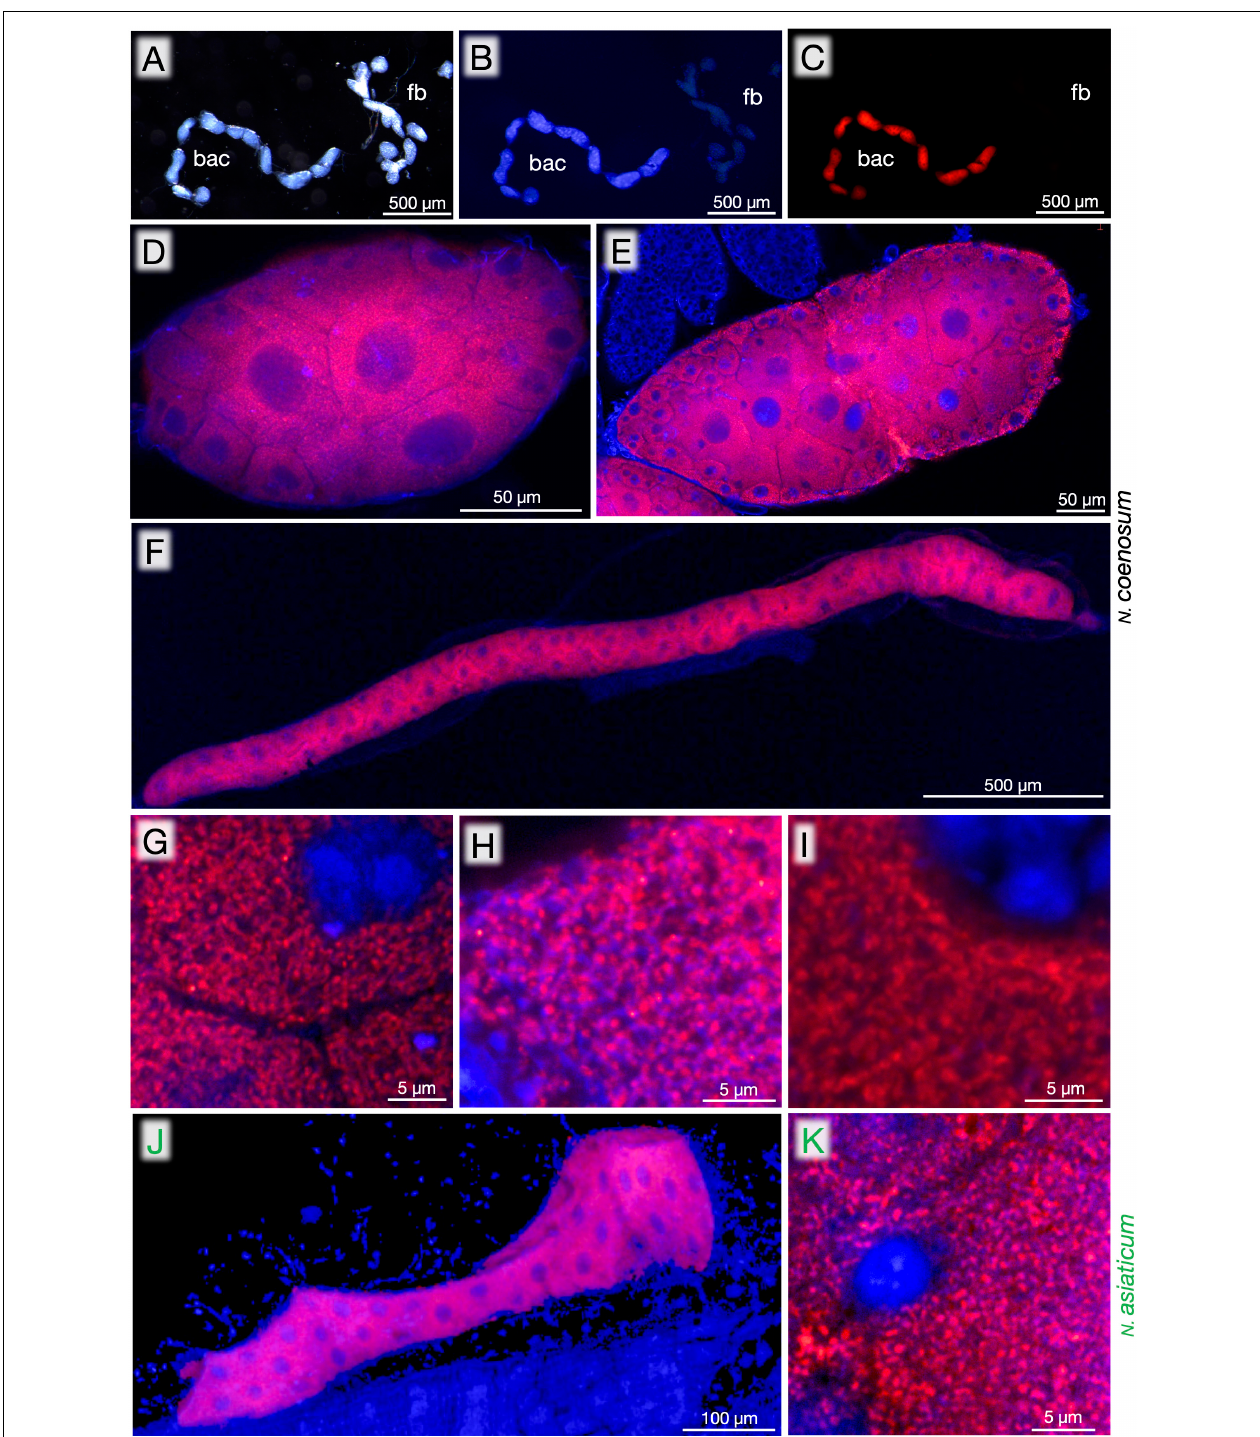
FIGURE 3 | Bacteriomes, bacteriocytes and endosymbiotic bacteria of Nosodendron beetles visualized by FISH. (A–C) Dissected bacteriomes (bac) and fat bodies (fb) of adult male of N. coenosum . (A) Light microscopic image. (B) Epifluorescence microscopic image in which DNA is visualized in blue. (C) Epifluorescence microscopic image in which the endosymbiotic bacteria are visualized in red. (D–I) Laser confocal microscopic FISH images of bacteriomes, bacteriocytes and endosymbiotic bacteria of N. coenosum . (D,G) Adult males. (E,H) Adult females. (F,I) Larvae. (D–F) Images of a whole bacteriome lobe. (G–I) Magnified images of the endosymbiotic bacteria in the host cytoplasm. (J,K) Laser confocal microscopic FISH images of the bacteriome (J) and the endosymbiotic bacteria (K) of larval N. asiaticum. Red signals represent the endosymbiotic bacteria visualized by FISH targeting 16S rRNA, whereas blue signals show DNA visualized by DAPI staining.